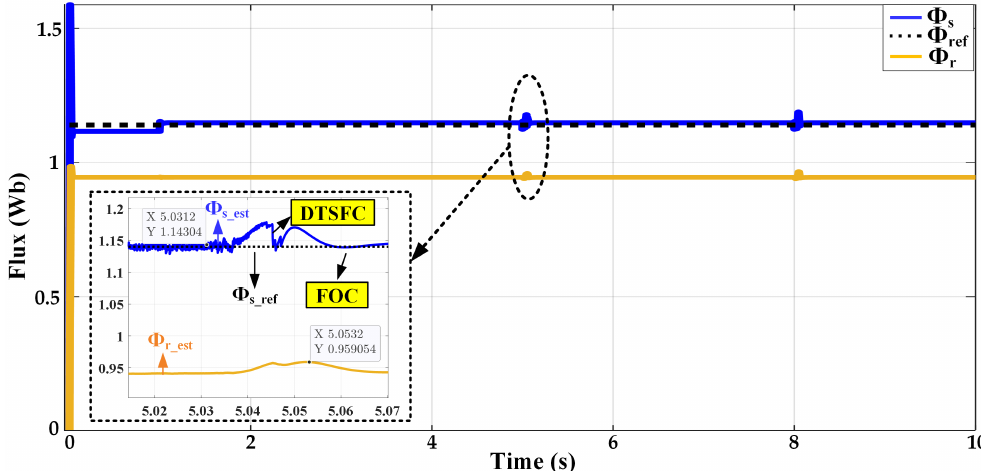
Figure 22. Stator and rotor responses of the proposed combined FOC-DTC algorithm.